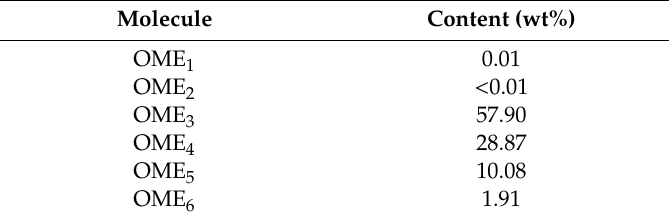
Table 2. Composition of OME x used in this study.